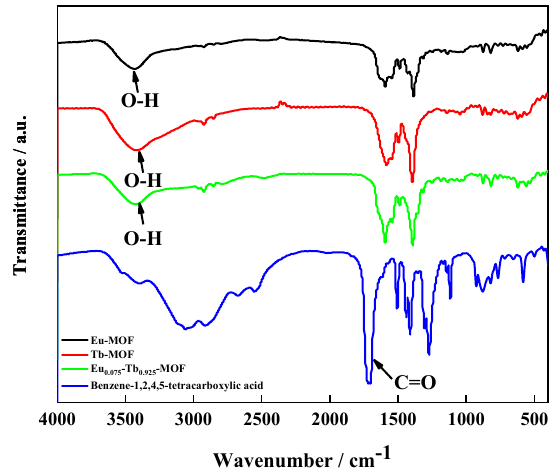
Figure 3. FTIR spectra of Benzene-1,2,4,5-tetracarboxylic acid and Ln-MOFs.